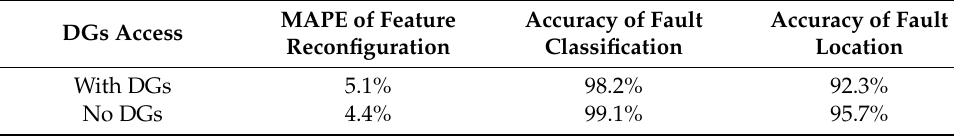
Table 6. Comparison results with DGs